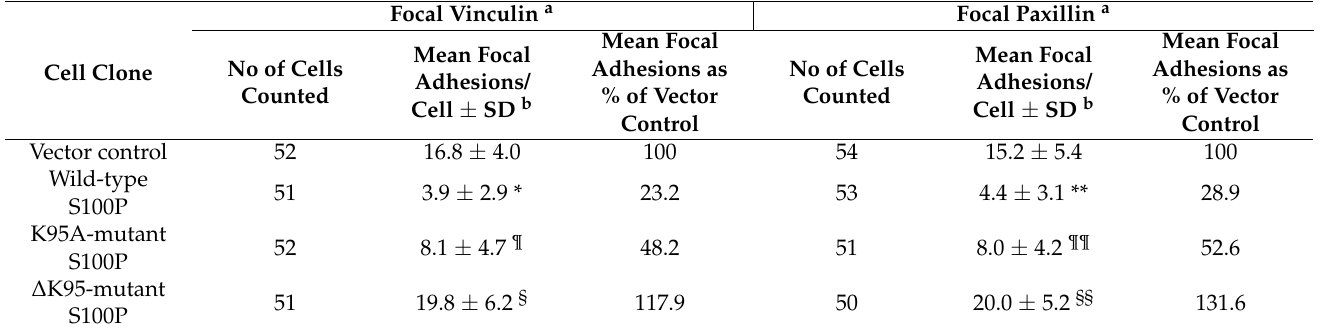
Table 2. Quantitation of focal adhesions in cell lines with and without metastatic